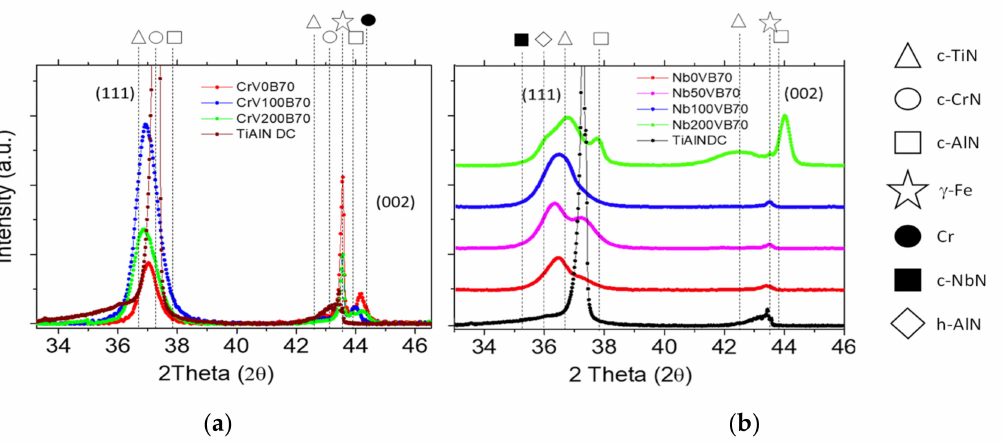
Figure 6. XRD spectra from (TiAl) 1 − x (Cr) x N ( a ) and (TiAl) 1 − x (Nb) x N ( b ) fillms applying different positive pulses on Cr, Nb targets during deposition. XRD spectrum from TiAlN DCMS film depicted for